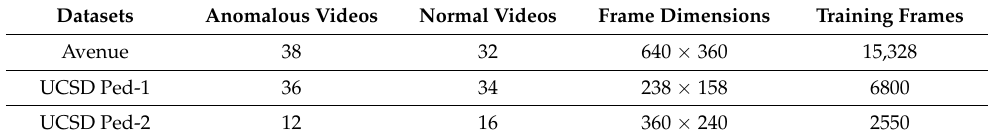
Table 1. Datasets Description.